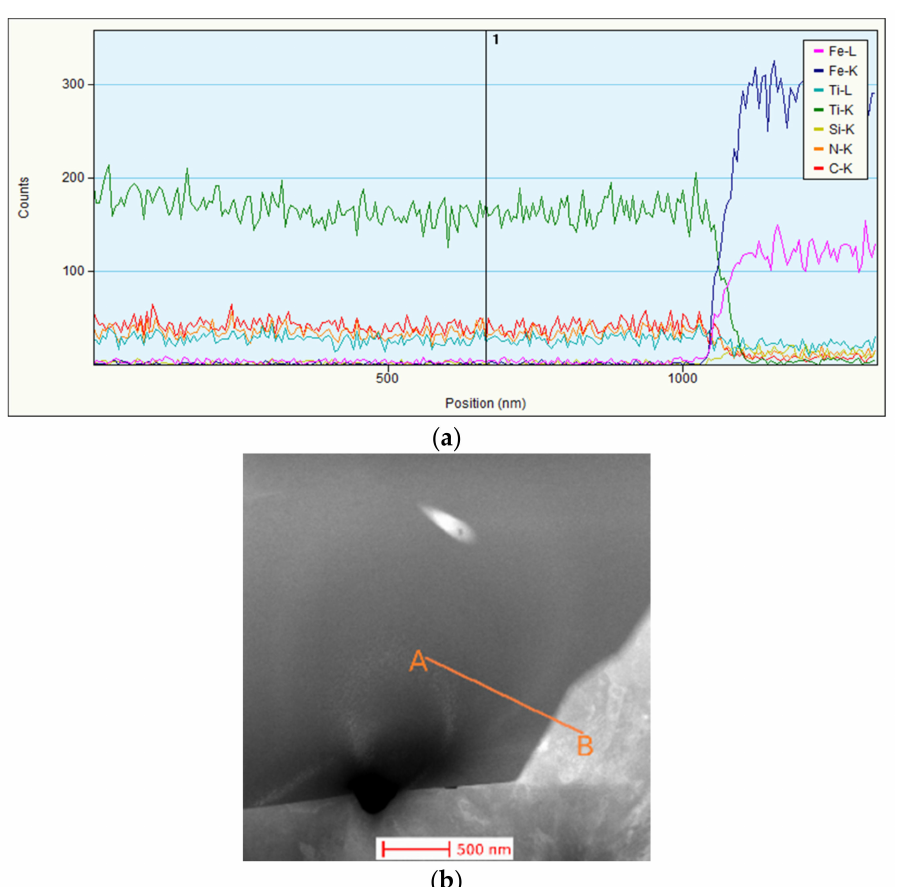
Figure 7. ( a ) The EDS line-scan profile of the composition of TiCN precipitate from TEM; ( b ) measur- ing line from A to B.